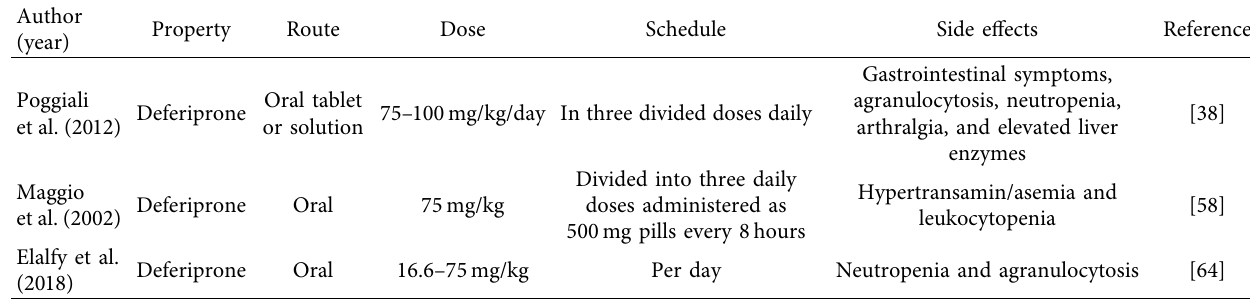
Table 2: Summary of the findings on